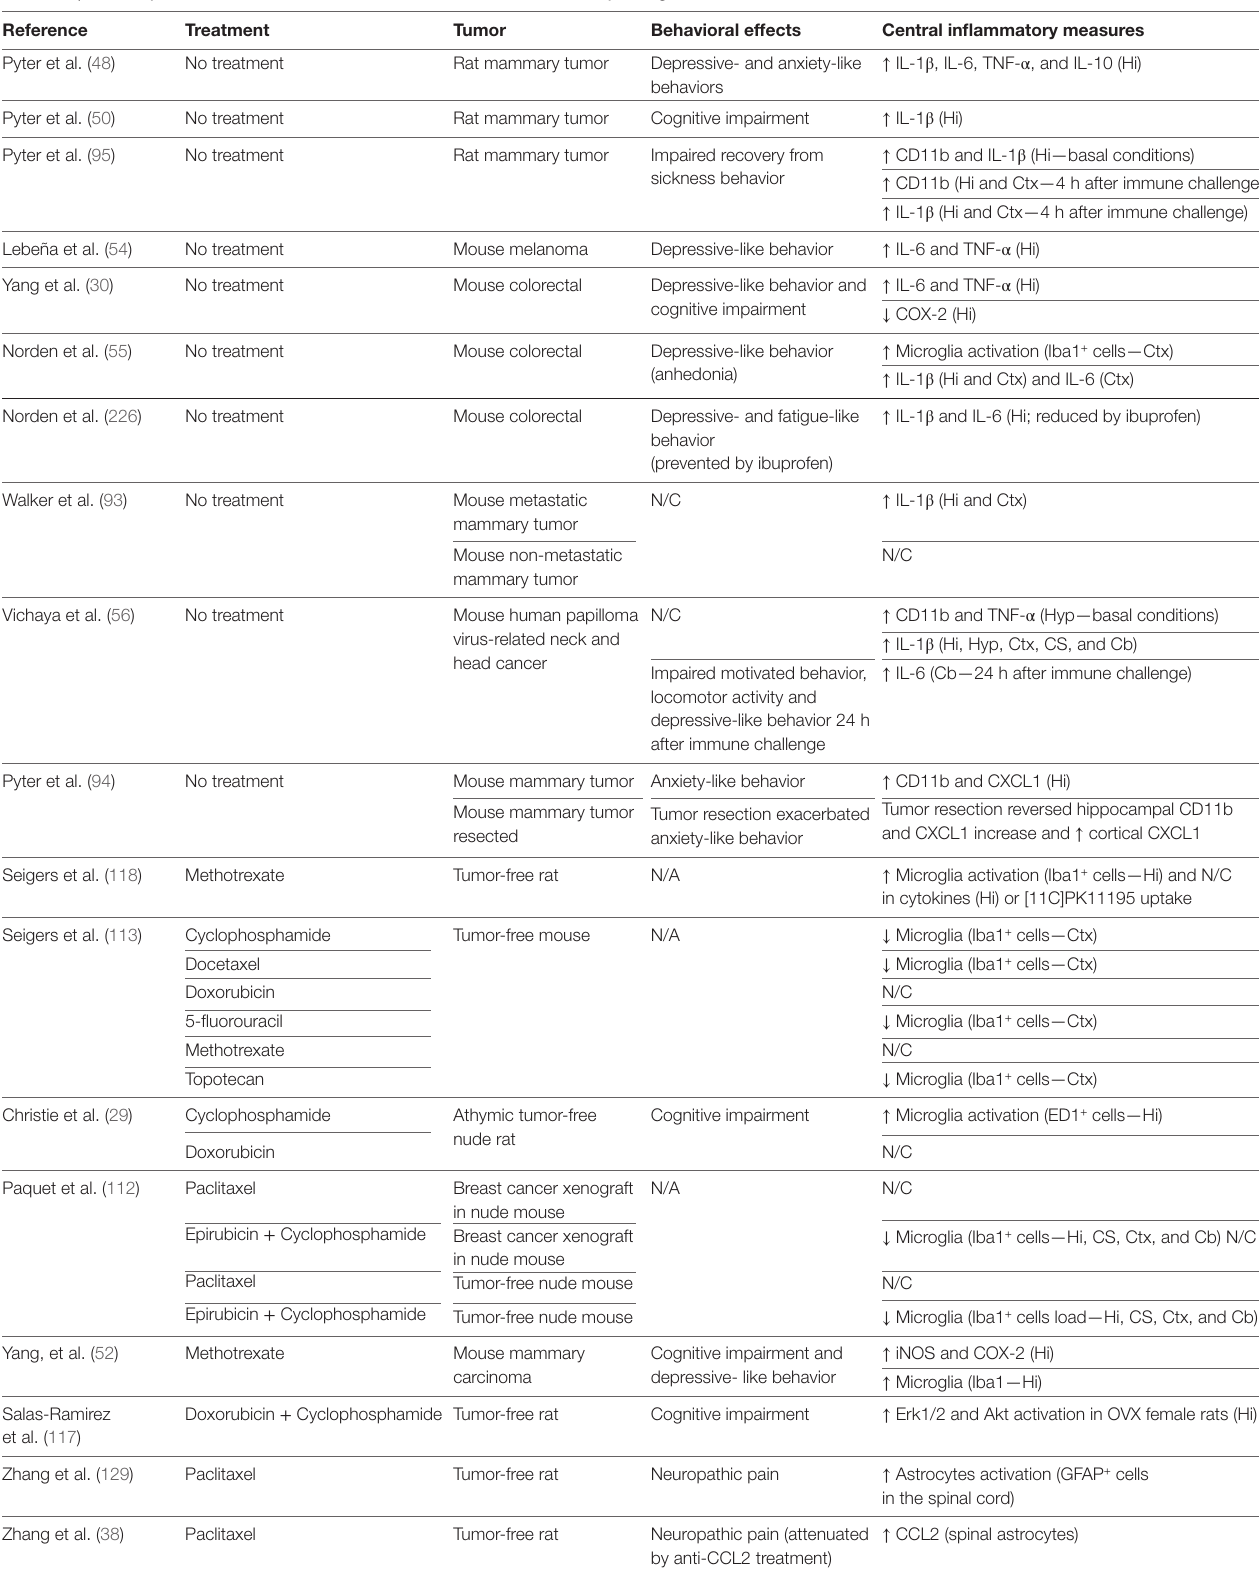
TABLe 1 | Summary of cancer- and cancer treatment-induced neuroinflammatory changes in rodents.